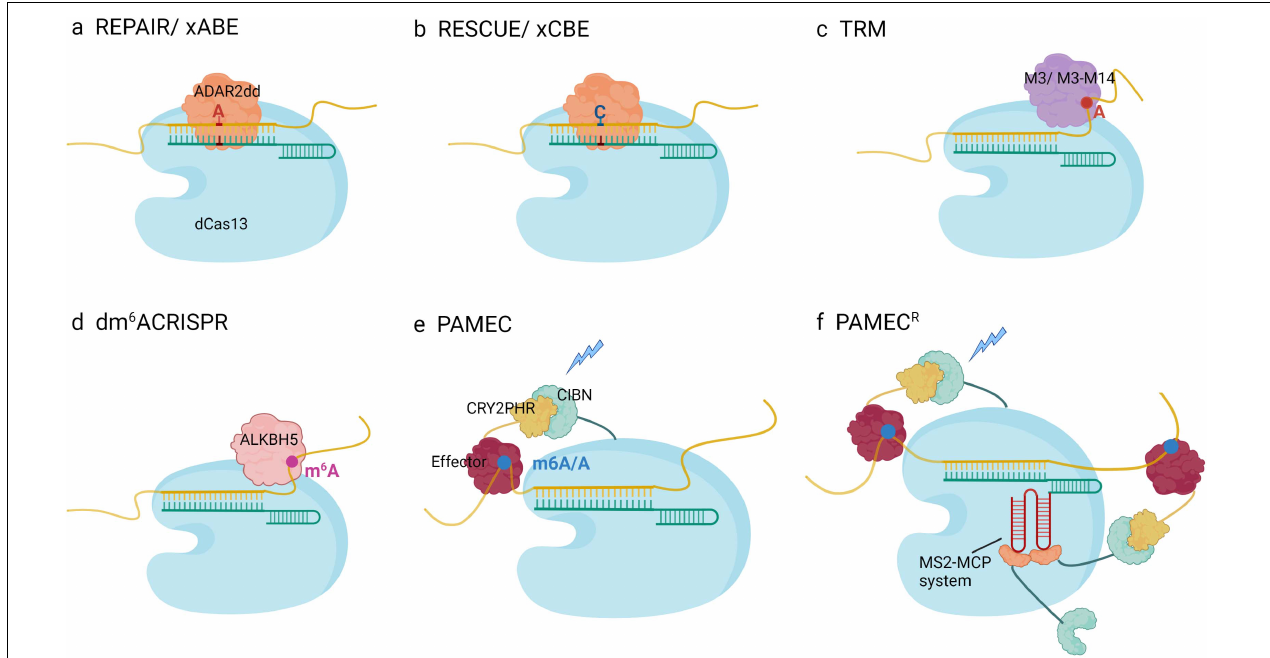
FIGURE 2 | Schematic diagram of RNA modification engineering platforms: (A) REPAIR/xABE (A-to-I editing platform): Specifically designed CrRNAs base-pair with RNA targets and recruit dCas13-ADAR2dd to the dsRNA, which deaminates adenosines to inosines in the dsRNA region. C-A mismatch in editing sites enhances the editing specificity. (B) RESCUE/xCBE (C-to-U editing platform): dCas13 is fused to evolutionary ADAR2dd, which performs increased cytidine deamination activity. With the guidance of CrRNA, dCas13-ADAR2dd mediates A-to-U transformation in the dsRNA. A mismatched uridine in the CrRNA opposite the target cytidine enhances the editing reaction. (C) The targeted RNA methylation (TRM) system: dCas13b fusions to modified methyltransferase domains, such as METTL3 (cid:49) ZF (M3) removing zinc finger RNA binding motif or constructed protein consisted with M3 and METTL3-interacting domain of METTL14 can selectively and efficiently install m 6 A in targeted adenosine. (D) dm 6 ACRISPR system: The targeted demethylation system is consist of a catalytically inactive Cas13b, full-length of demethylase ALKBH5 and gRNA, which enable to demethylate either close or remote m 6 A modifications. (E) Photoactivatable RNA m 6 A editing system using CRISPR-dCas13 (PAMEC): PAMEC harnesses CIBN-CRY2, a robust light-dependent protein–protein interaction system. Under the explosion of blue light, the RNA anchor probe including CIBN and dCas13b and the effector probe containing RNA editing effector and CRY2 tight together and form a functional unit for m 6 A installation and erasure. (F) PAMECR: RNA–protein interaction system, MS2-MCP, is further introduced to primary PAMEC platform, which ensures manipulation of multiple transcripts robustly and